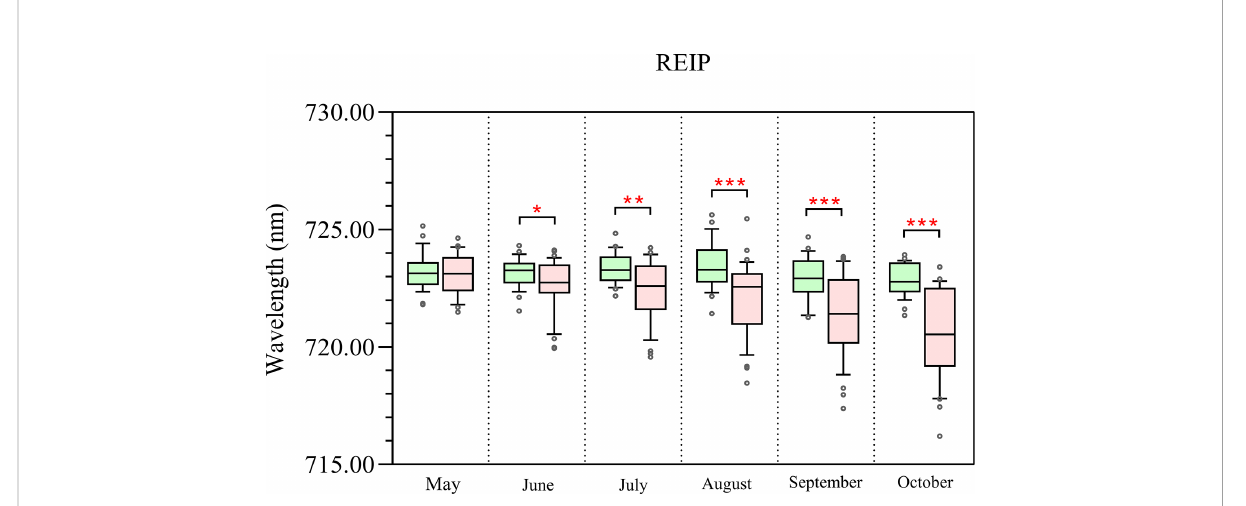
FIGURE 8 Temporal changes of the REIP derived from spectra of control (green) and infested trees (pink) over time. The symbol * indicates signi fi cant differences, with *, **, and *** indicating differences at p < 0.05, p < 0.01, and p < 0.001, respectively.